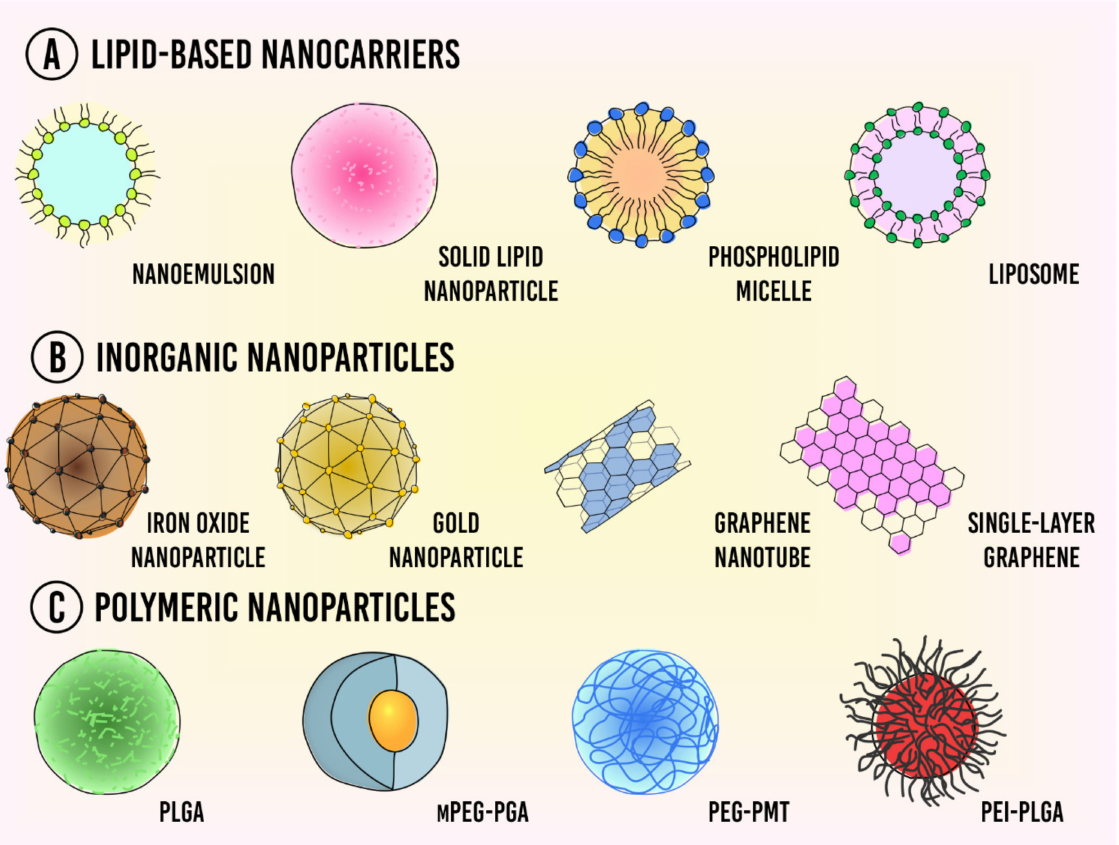
Figure 1. Types of nanocarriers used for drug delivery in cancer therapy. ( A ) Lipid-based nanocarriers; ( B ) Inorganic nanoparticles; ( C ) Polymeric